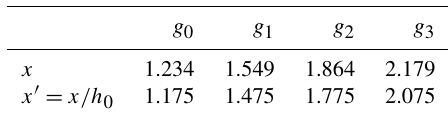
Figure 5. BP1. Filtered data (in red) and numerically simulated (in blue) time series at wave gauges (a) g 0 , (b) g 1 , (c) g 2 , and (d) g 3 . Table 2. Values for variables defining setup configuration.